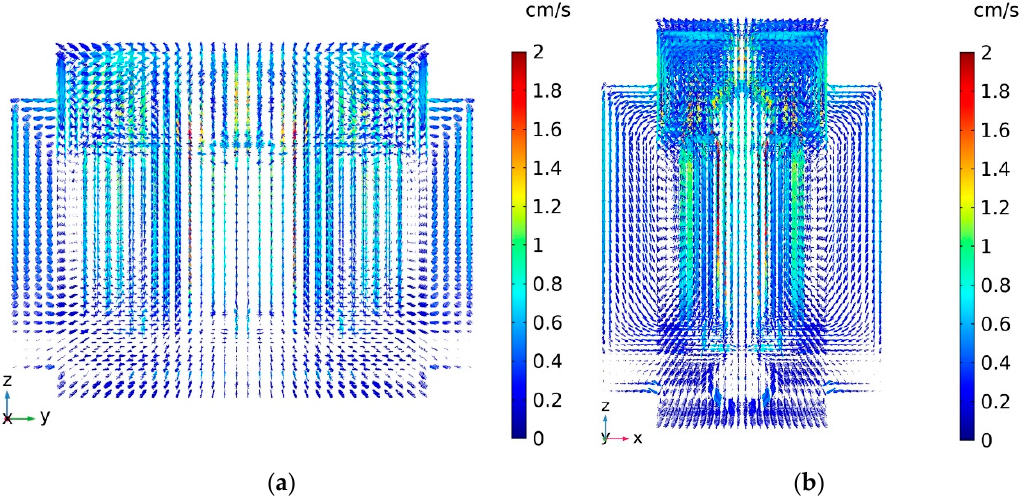
Figure 15. Oil stream vector diagram from the ( a ) front view and ( b ) side view.